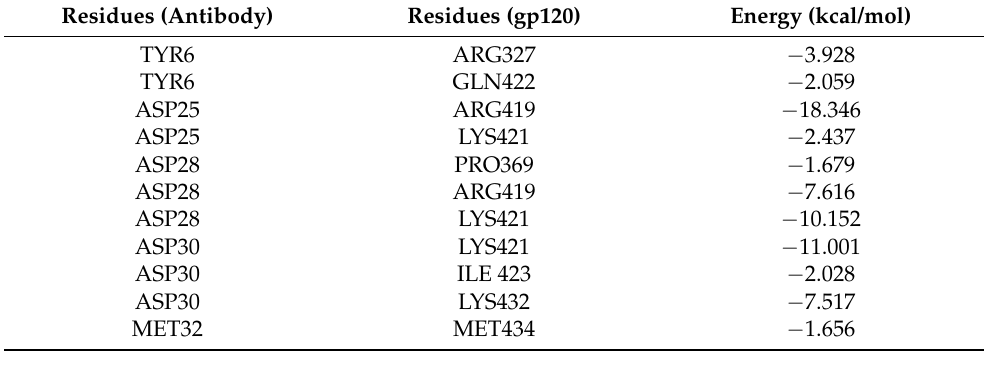
Figure 6. The RMS deviations for NBD-557 in all three MD simulations, i.e., with gp120, in Asn425Gly mutant and with antibody. Note that all results are reported for the most populated trajectories of 100 ns. Table 3. The interaction between antibody and gp120 residues. Here antibody residue numbering starts from 1 and it is different from gp120 numbering. Table 2. Energy contribution when GP120 binds with NBD in Asn425Gly Mutant. All abbrevia- tions have the same meaning as defined in Table 1.